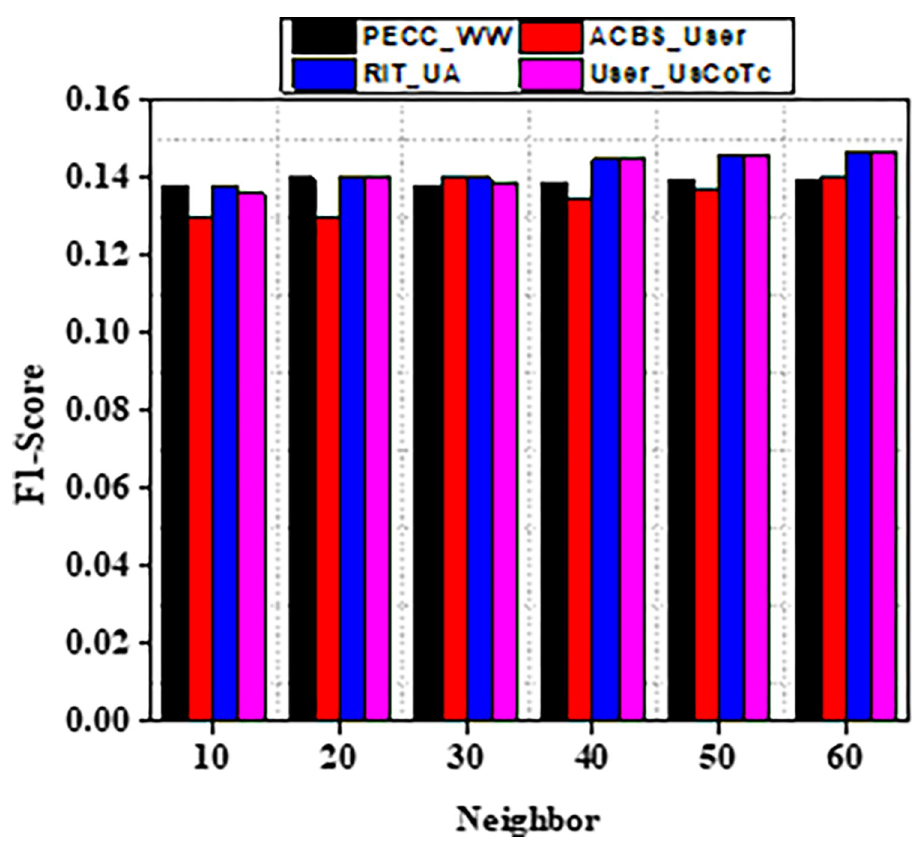
Fig 15. F1-measure with various